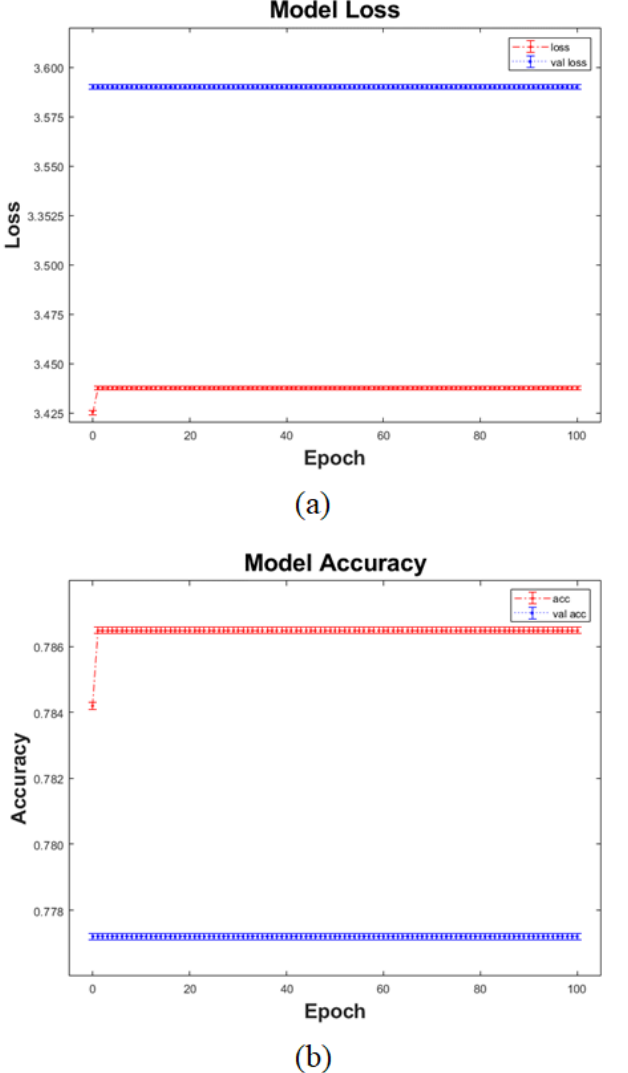
Figure 11. History graphs of the CNN model in terms of loss and accuracy. ( a ) Loss graph and ( b ) accuracy graph.